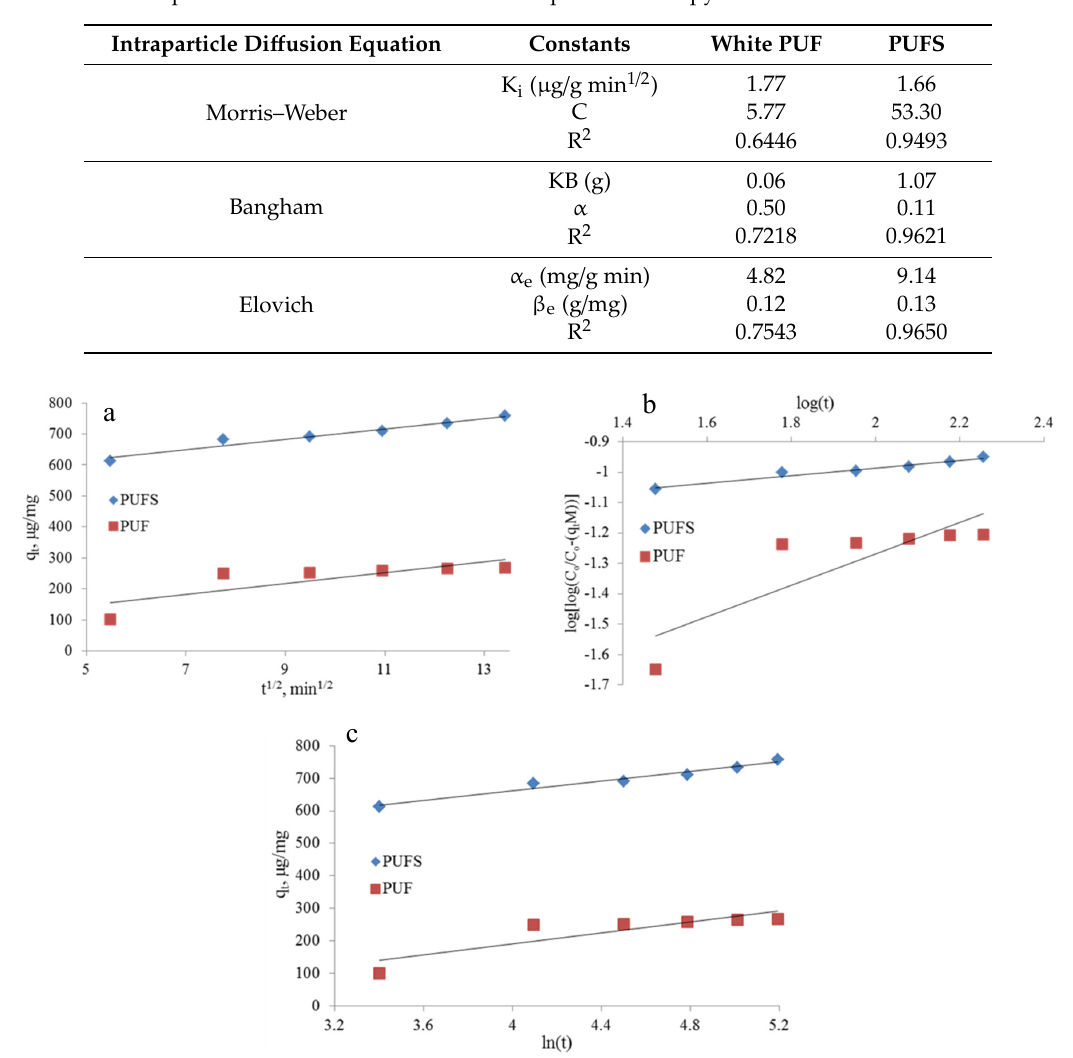
Figure 12. ( a ) Intraparticle diffusion model by Morris–Weber model, ( b ) Bangham model and ( c ) Elovich models for the sorption of CPF onto white PUF and PUFS.